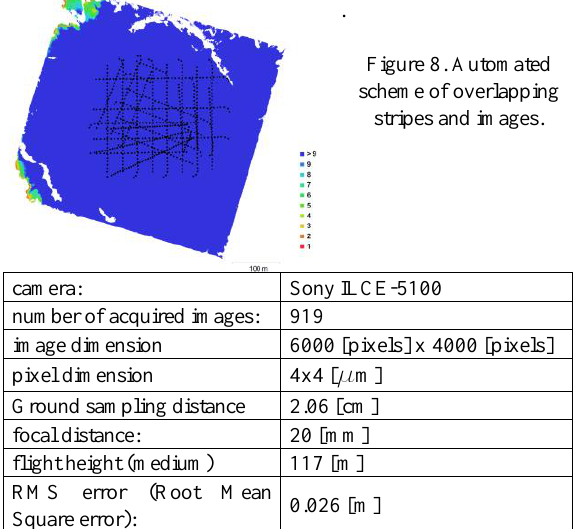
. Figure 8. Automated scheme of overlapping stripes and images.